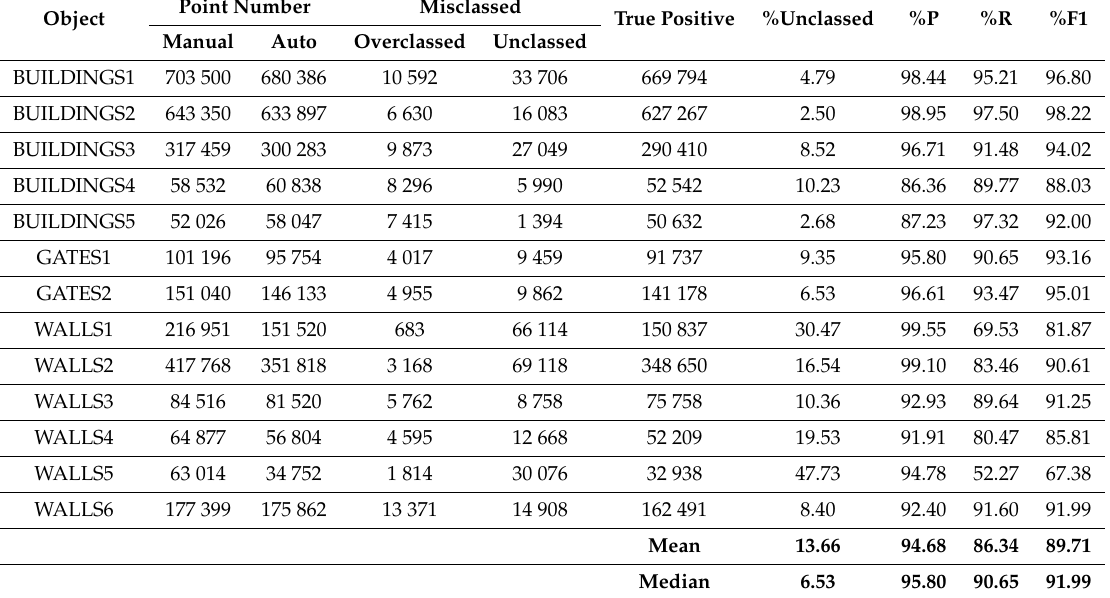
Table 1. The quantitative analysis on the results of step 1 for Kasepuhan. In this table, three classes were taken into account (buildings, gates, and walls) with a total of 13 objects. %P is precision, %R is recall, and %F1 is the normalized F1